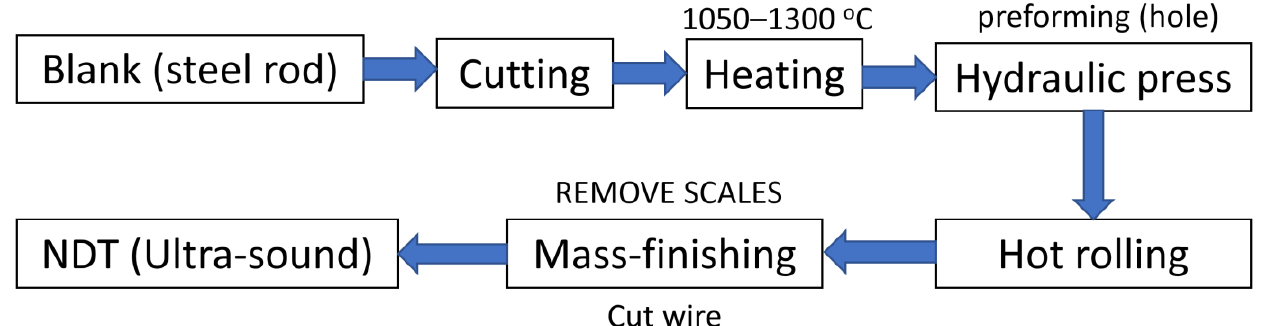
Figure 1. Diagram of technological process.